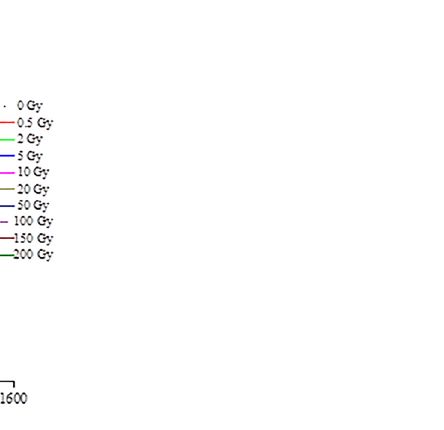
Figure 5. The intensity ratio I D / I G against 1 / L a , I D / I G corresponding to inset shows the labelled points corresponding to the given doses.